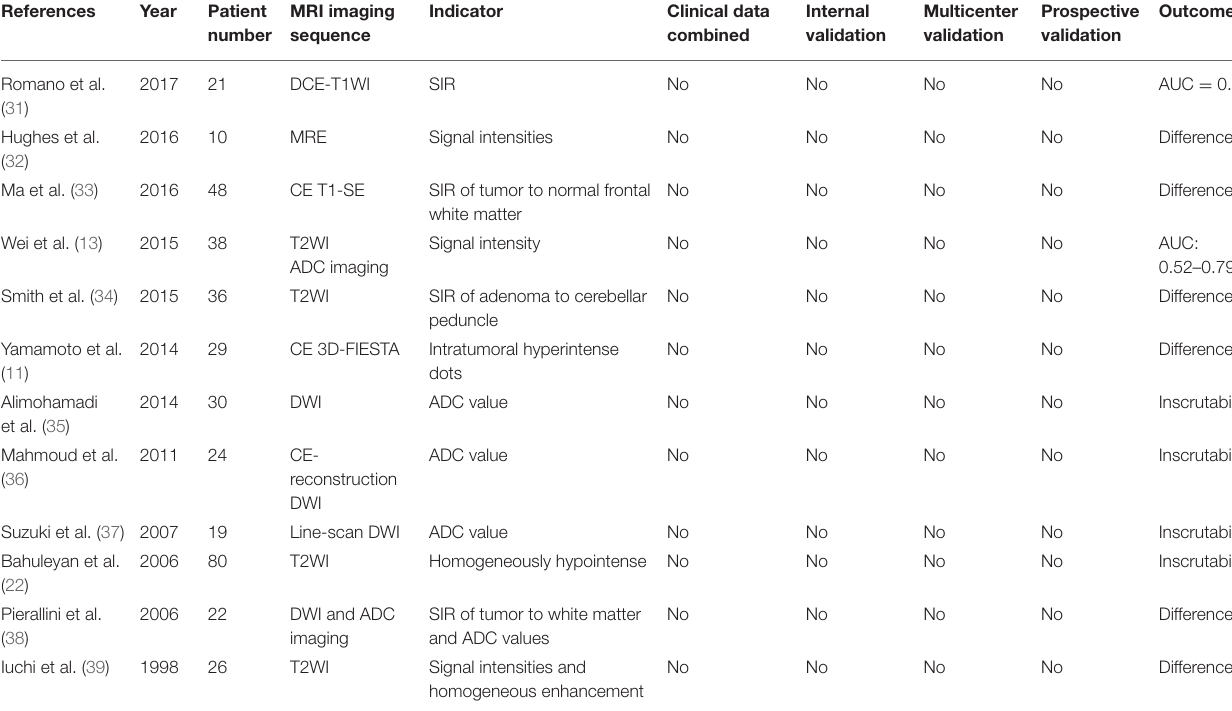
TABLE 5 | Summary of the method and outcome of previous PA consistency prediction